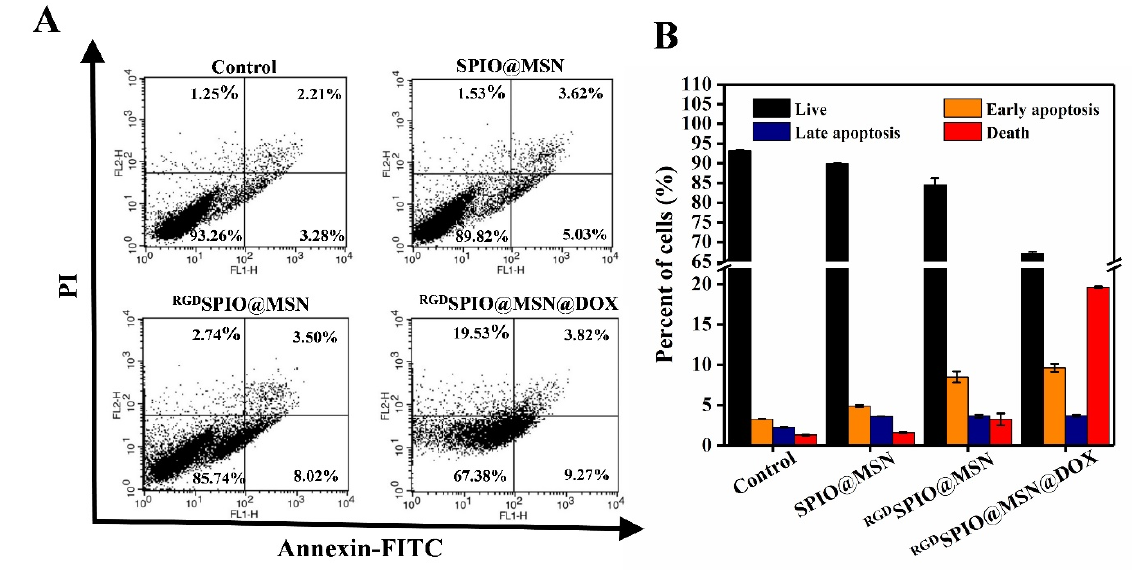
Figure 7. Apoptosis assay of the treated HepG2 cells by flow cytometry. ( A ) HepG2 cells stained using Annexin V ‐ FITC/PI after different treatments, and ( B ) the corresponding quantitative analysis of various stages.